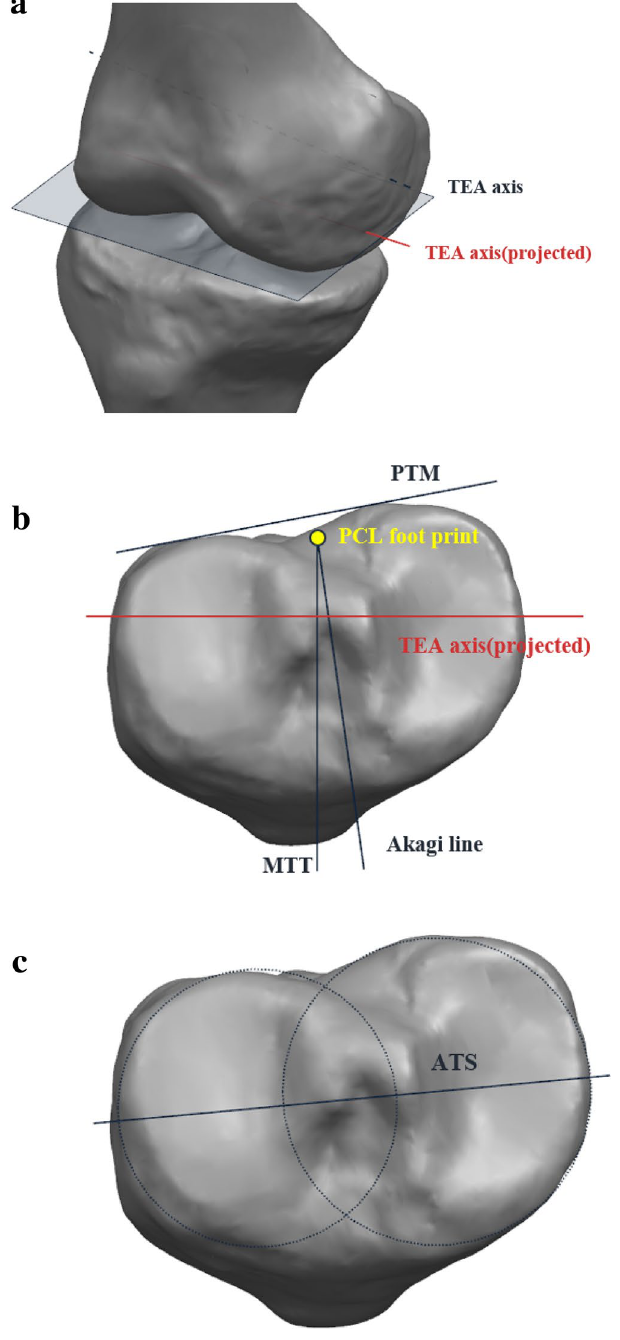
Figure 1. Schematic representation of ( a ) TEA, ( b ) PTM, MTT, Akagi line, and ( c )